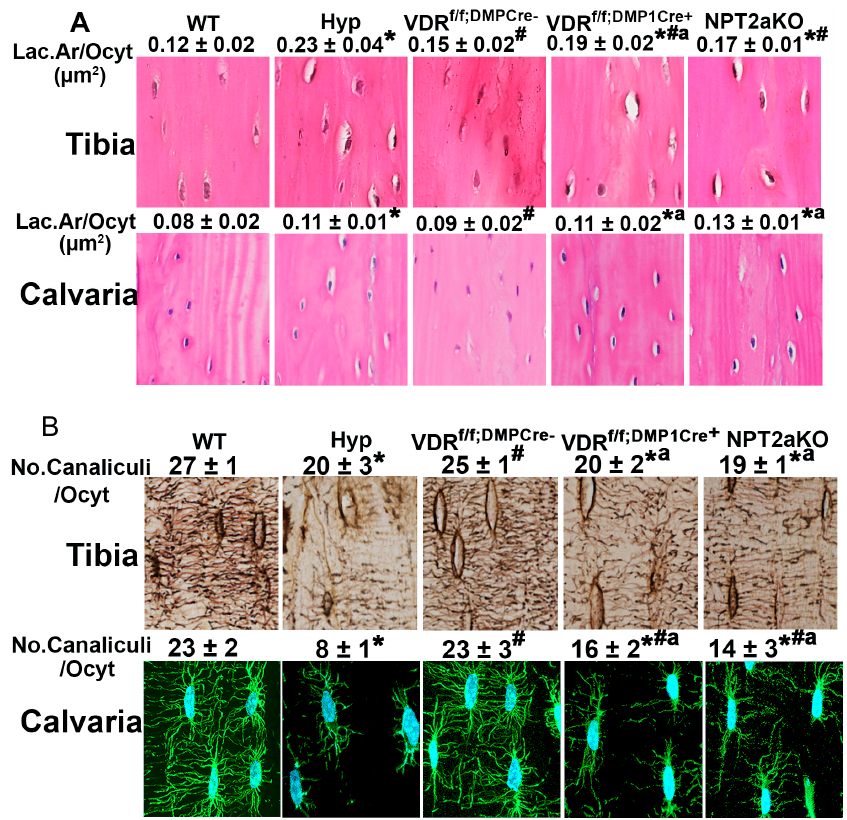
Figure 1. Decreased 1,25D action and hypophosphatemia contribute to the impaired lacuno-canalicular (LCN) organization seen in XLH: ( A ) H&E stain of post-natal day (P) 30 tibiae and P75 calvariae from wild-type (WT) and Hyp mice and mice lacking the vitamin D receptor in osteocytes (VDR f/f;DMP1Cre+ ) and mice lacking the sodium phosphate transporter 2a (NPT2aKO) with histomorphometric quantitation of the lacunar area per osteocyte (Lac.Ar/Ocyt). ( B ) Silver stain of P75 tibial canaliculi and phalloidin labeling of P30 calvarial canaliculi with number of canaliculi/ocyt (No. canaliculi/ocyt). Like Hyp mice, VDR f/f;DMP1Cre+ and NPT2aKO mice have enlarged osteocyte lacunae and abnormal canalicular structure in both tibia and calvariae, indicating that the impaired 1,25D and phosphate actions in Hyp mice underlie the abnormal LCN structure seen in XLH. All data shown were previously published [65]. * = p < 0.05 vs. WT, # = p < 0.05 vs. Hyp, a = p < 0.05 vs. VDR f/f;DMP1Cre − . The figure is modified from Yuan et al. [65] and there are no issues with